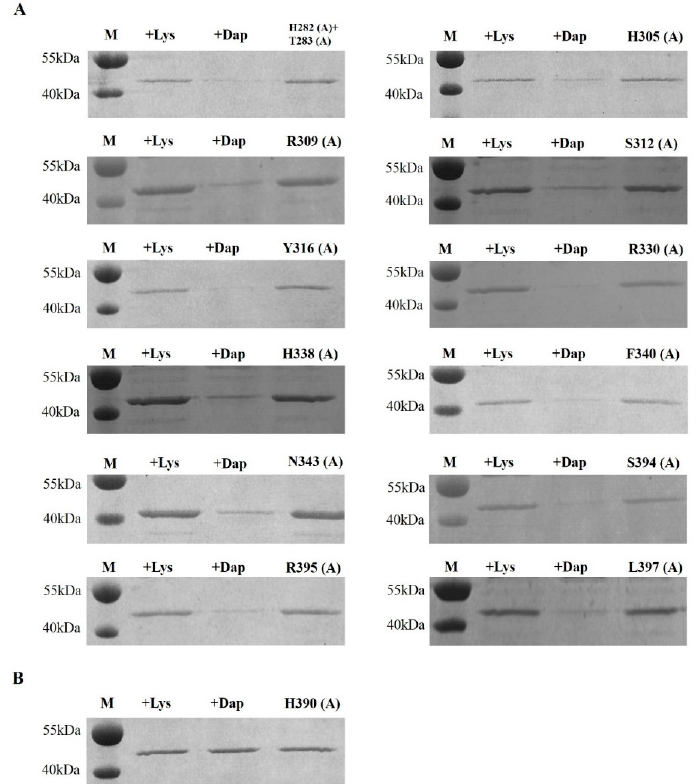
Figure 3. Analysis of the PGN-binding ability of the bumblebee Bombus lantschouensis PGRP-LC (Bl-PGRP-LC) mutants. Each sample includes four lanes. The first lane (M) is the marker; the second lane ( + Lys) shows the corresponding protein samples after pull-down with the Dap-type PGN from B. subtilis ; the third lane ( + Dap) shows the corresponding protein samples after pull-down with the Lys-type PGN from M. luteus ; and the fourth lane shows the Bl-PGRP-LC mutant protein. ( A ) Analysis of the PGN-binding ability of the twelve Bl-PGRP-LC mutants, namely, H283A and T283A, H305A, R309A, S312A, Y316A, R330A, H338A, F340A, N343A, S394A, R395A and L397A. ( B ) Analysis of the PGN-binding ability of the Bl-PGRP-LC mutant